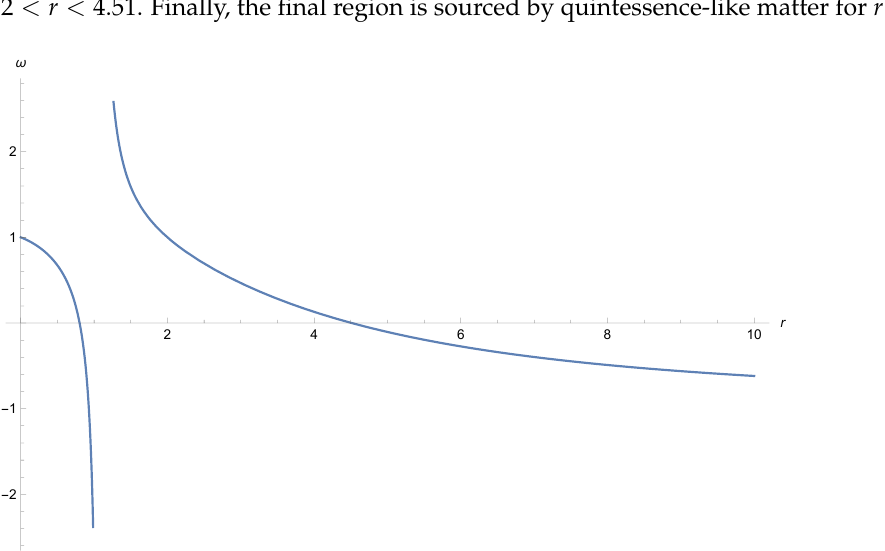
Figure 4. Plot of ω ( r ) for a zero-tidal Schwarzschild-like wormhole with an excess of solid angle ( β < 0) for ξ = 1, r 0 = 1, and β = −